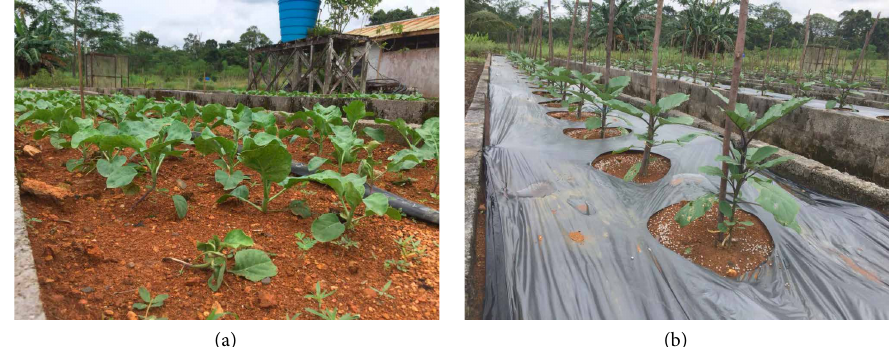
Figure 1: Photographs of field experiments for (a) Chinese kale and (b)